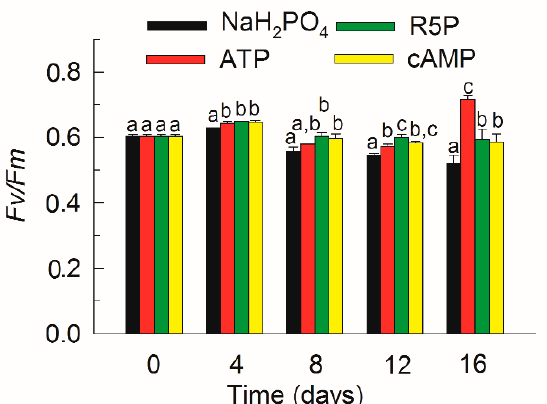
Figure 3. Fv/Fm of Karenia mikimotoi in the NaH 2 PO 4 , adenosine triphosphate (ATP), ribulose 5 ‐ phosphate (R5P), and cyclic adenosine monophosphate (cAMP) treatments on days 0, 4, 8, 12, and 16. The values are the mean ± S.D. ( n = 3). Significant differences ( p < 0.05) among different phosphorus substrates are shown with different lowercase letters.